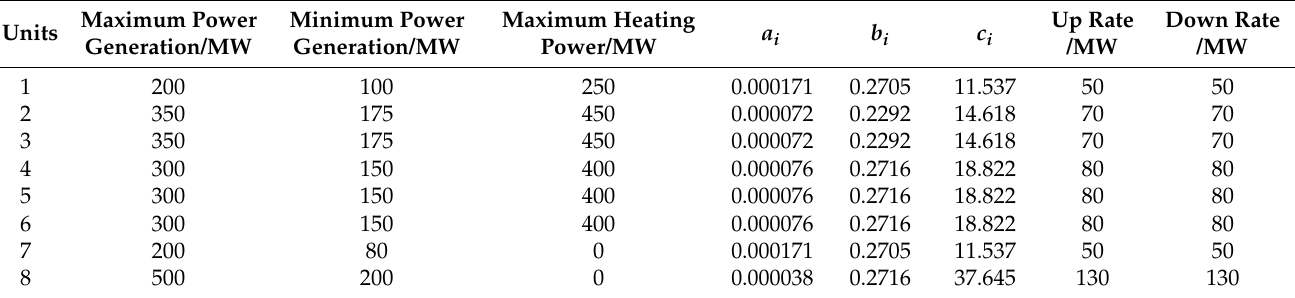
Table 7. Unit parameters.